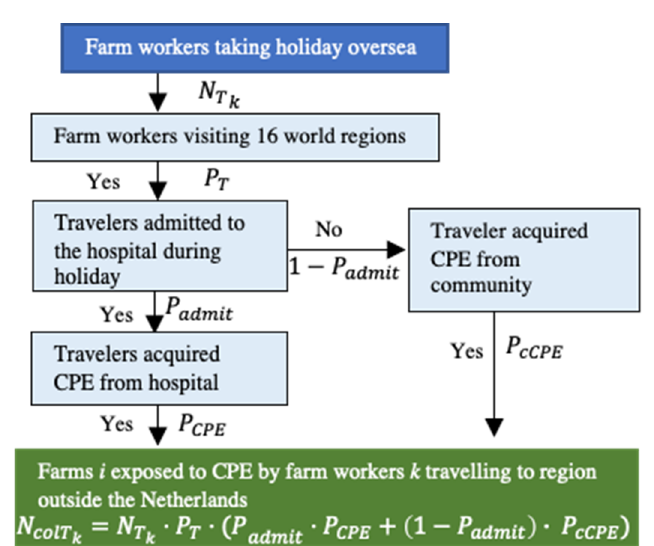
Figure 5. Scenario tree to calculate the number of farms exposed to CPE by farm workers returning from travel abroad.